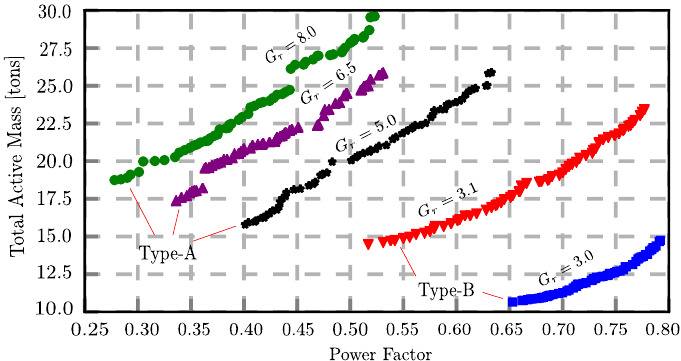
Figure 15. Total active mass vs. power factor for 3MW PMVMs (©[2020] IEEE. Reprinted, with permission from [20]).